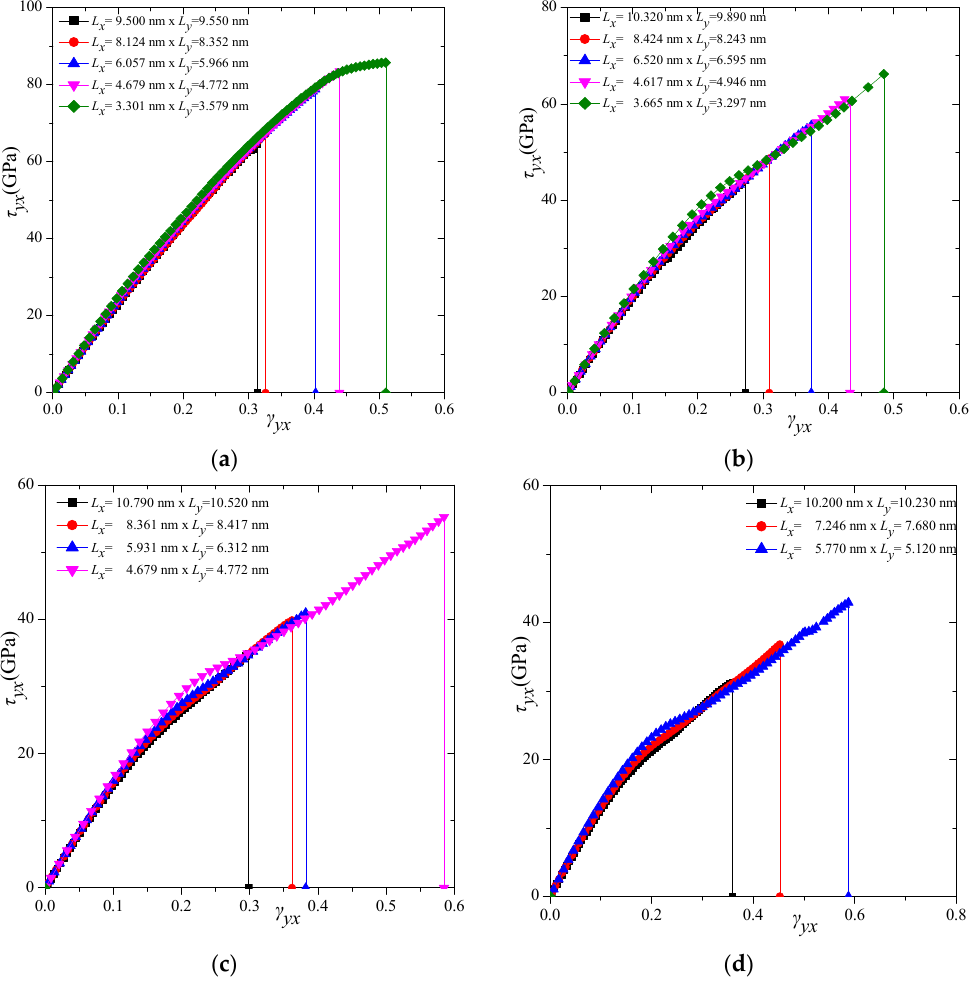
Figure 4. Shear stress–strain response of ( a ) graphyne, ( b ) graphdiyne, ( c ) graphyne-3, and ( d ) graphyne-4 structures in y–x direction.